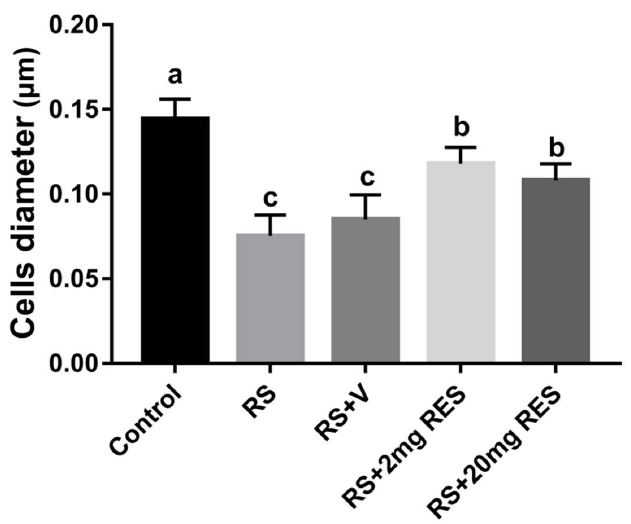
Figure 5. Effects of resveratrol on the parietal cell diameter of non-stressed mice (Control), restraint-stressed mice (RS), restraint-stressed mice with vehicle (RS + V), restraint-stressed mice treated with 2 mg/kg body weight of resveratrol (RS + 2 mg RES), and restraint-stressed mice treated with 20 mg/kg body weight of resveratrol (RS + 20 mg RES). Statistical differences were determined by 1-way ANOVA followed by Tukey’s multiple-comparison test. Different superscript letters represent significant differences among groups ( p < 0.05).